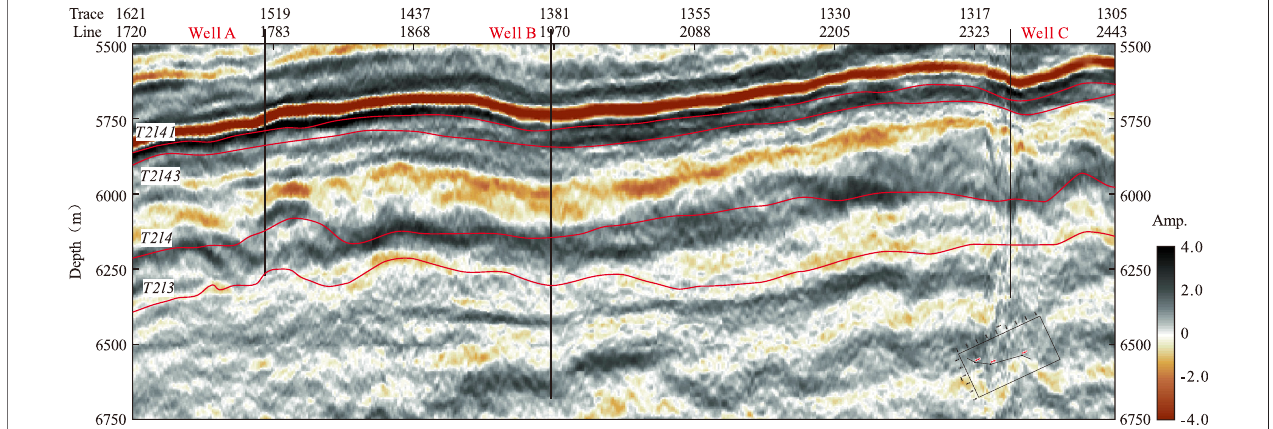
FIGURE 12 | Results of the pro fi le after time-depth conversion.